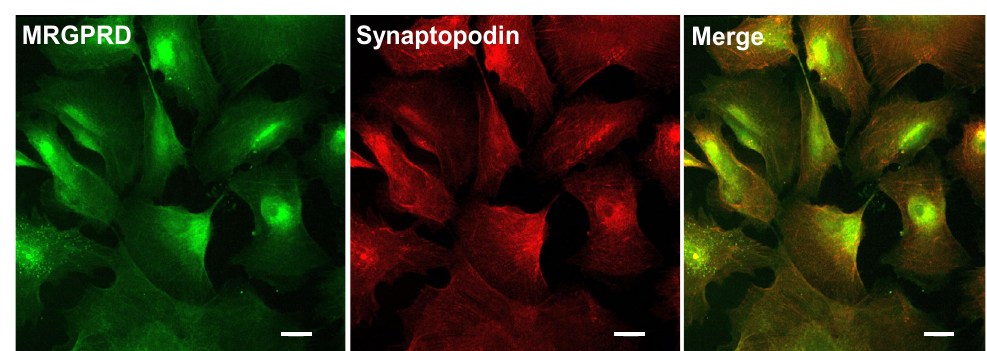
Figure 1. Human podocytes express extracellular L-BAIBA stimulation-sensitive MRGPRD. ( A ) MRGPRD protein expression in podocytes before and after L-BAIBA treatment (10 µM) for 24 h, 2 days, and 5 days. n = 9. * p < 0.05, ** p < 0.01, *** p < 0.001. ( B ) Representative immunoblot membranes. ( C ) MRGPRD mRNA expression levels in podocytes before and after L-BAIBA treatment (10 µM) for 24 h, 2 days, and 5 days. n = 7–9. * p < 0.05, ** p < 0.01. ( D ) Representative agarose gel with PCR products. (E) Confocal images of podocytes immunostained for MRGPRD and the podocyte marker synaptopodin. Scale bar = 10